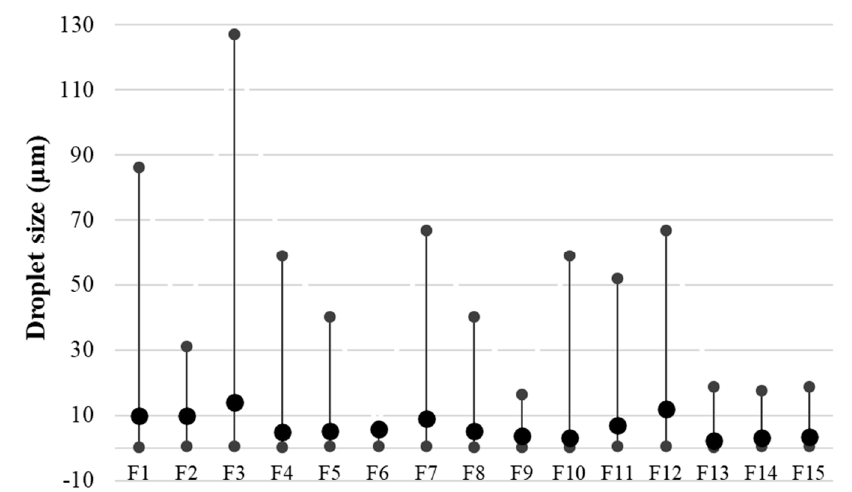
Figure 8. Minimum, mean and maximum droplet size of the freshly prepared emulsions.